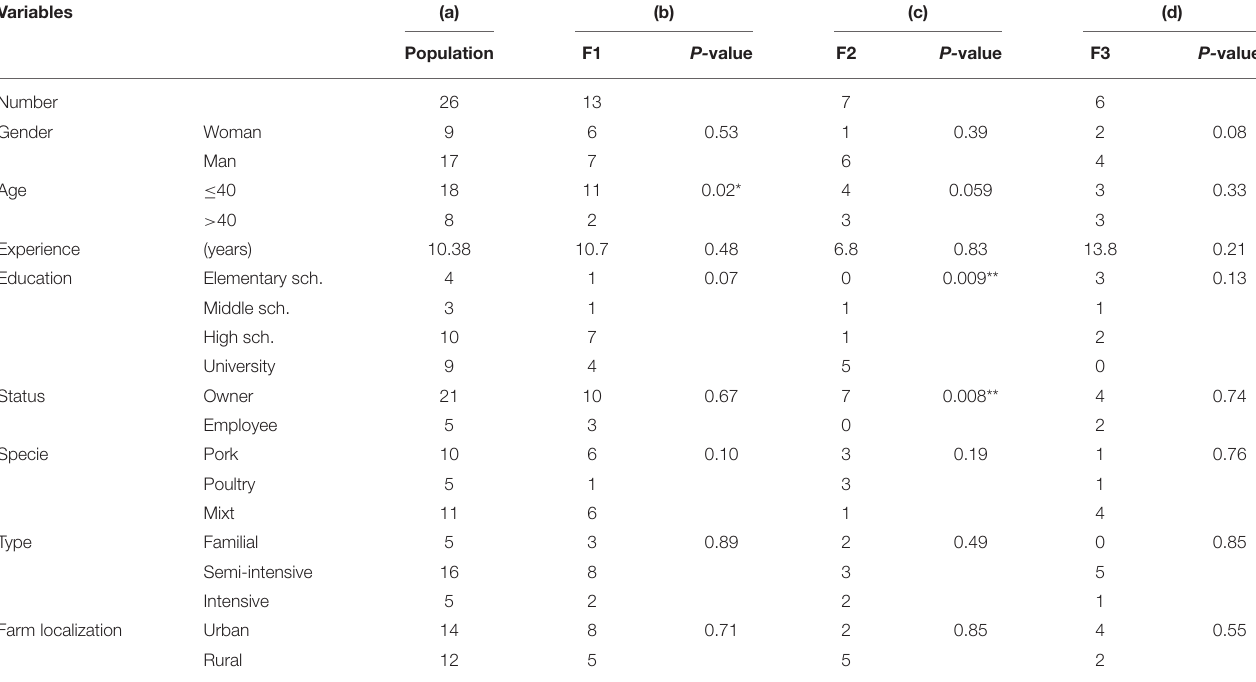
TABLE 1 | Socio-demographic variables and result of Kruskal-Wallis test for the whole population of breeders (a), people belonging to F1 (b), F2 (c), and F3 (d).